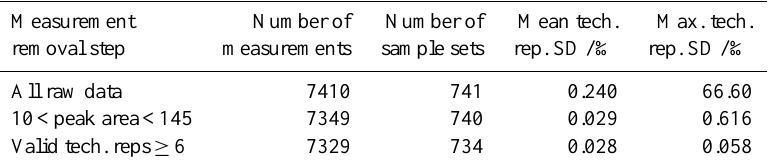
Table 3. Summary of the anomalous measurement removal process for all of the seawater samples. Numbers in each row are for all data after application of the measurement removal step indicated in the first column. Tech. rep. SD: standard deviation of uncalibrated δ 13 C DIC , calculated for each sample’s set of 10 technical replicates.